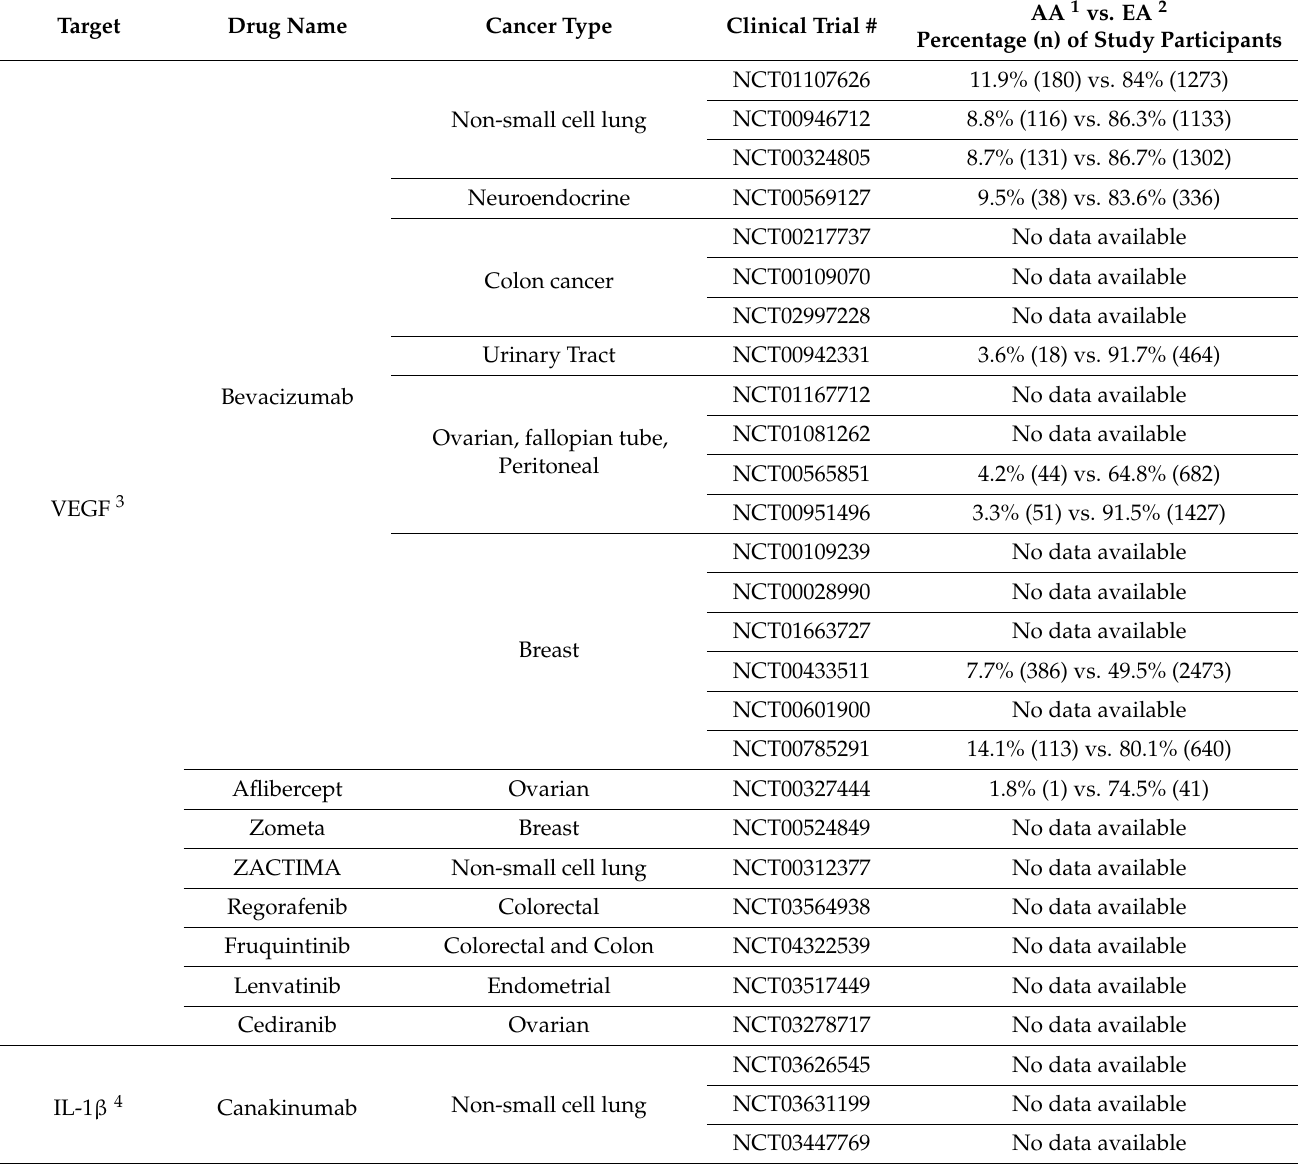
Table 1. Therapeutic agents targeting tumor microenvironment components/pathways in interventional phase 3 and 4 clinical trials currently active and recruiting or not yet recruiting. Data acquired from the USA National library of medicine (http://clinicaltrials.gov, accessed on 16 March